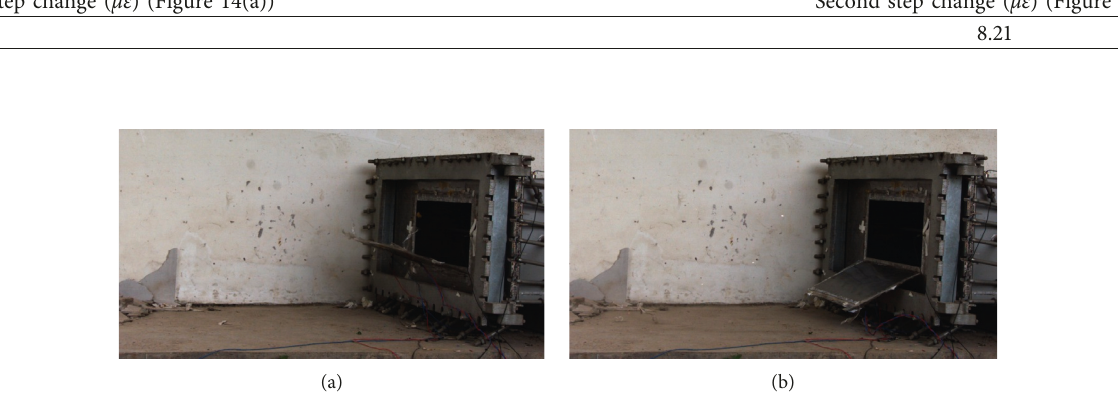
Figure 14: The flame front passing phase of the first test. (a) First step change. (b) Second step change. Table 1: Strain amplitude formed by the flame front passing through the FBG sensor in the first test. First step change ( με ) (Figure 14(a)) Second step change ( με ) (Figure 14(b))